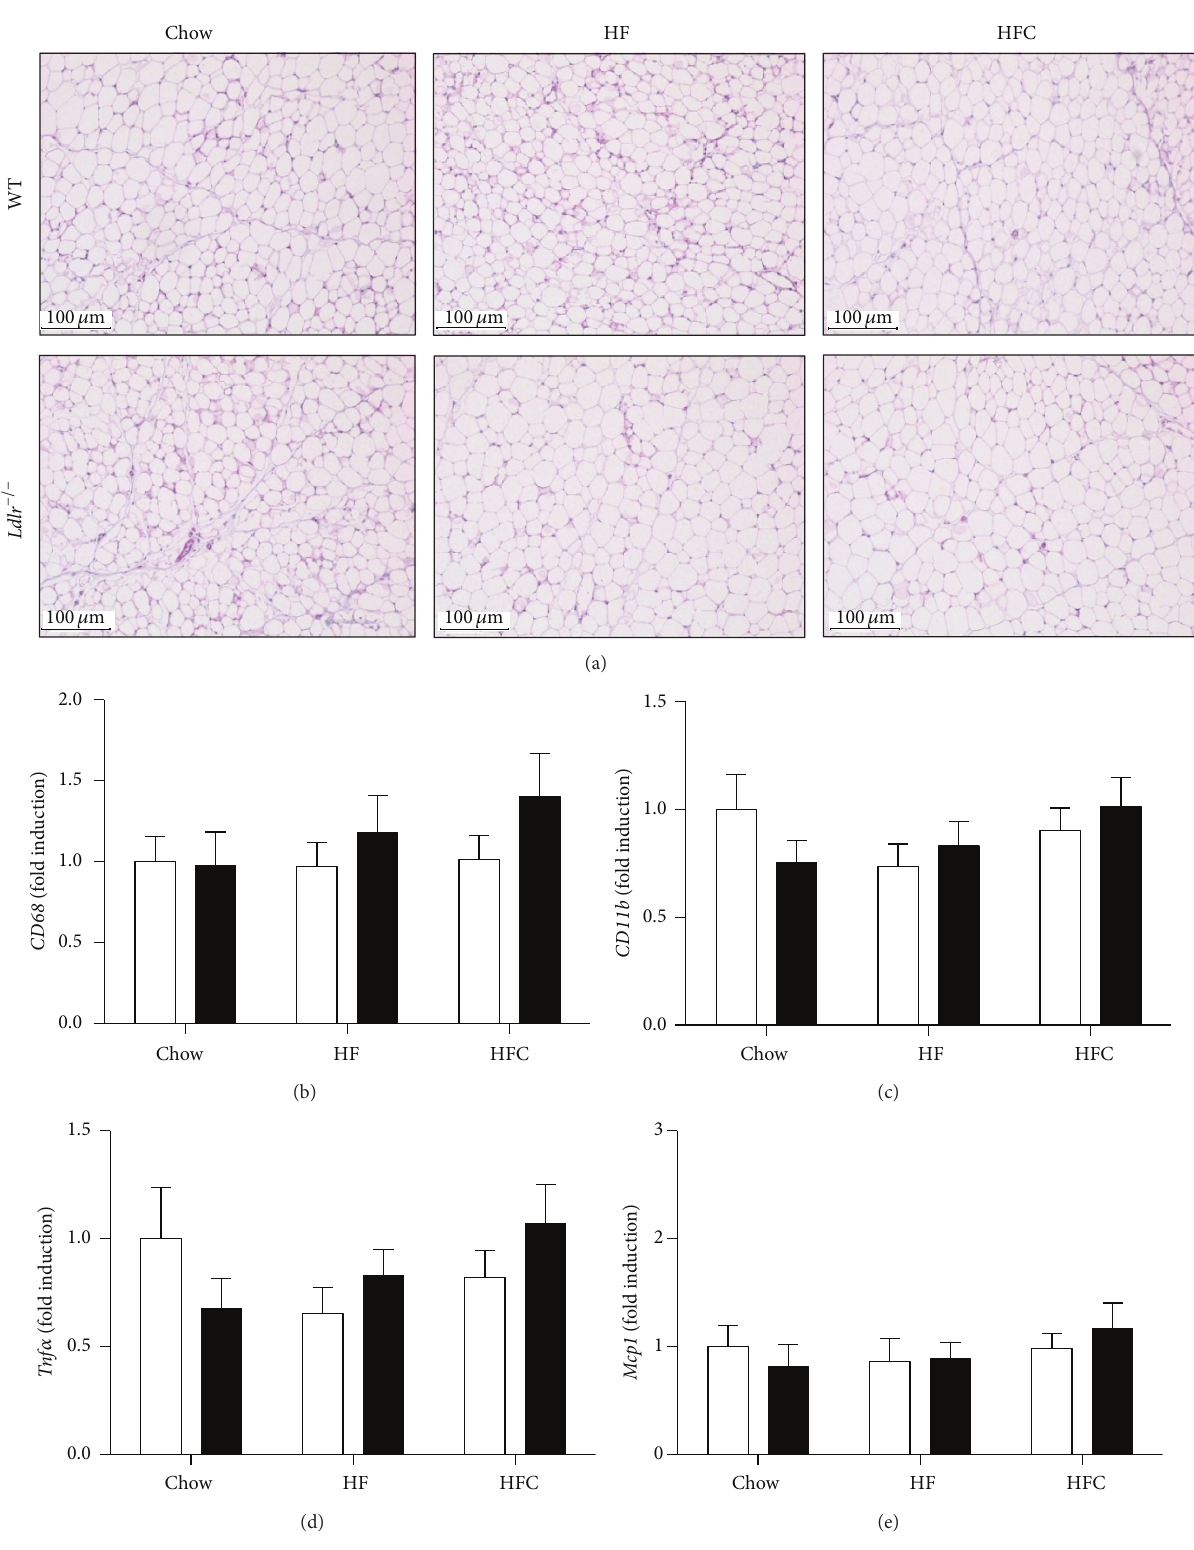
Figure 3: Absence of adipose tissue inflammation in Ldlr −/− mice fed a chow, HF, or HFC diet for 2 weeks. Representative pictures of paraffin- embedded white adipose tissue sections stained with hematoxylin-eosin (a) were taken from WT and Ldlr −/− mice fed a chow, HF, or HFC diet ( 𝑛 = 5-6). RNA was isolated from white adipose tissue and the expression of the proinflammatory genes Cd68 (b), Cd11b (c), Tnfa (d), and Mcp1 (e) was determined by real-time PCR and expressed as fold induction ( 𝑛 = 11 -12). Data are expressed as means ± SEM for WT mice (white bars) and Ldlr −/− mice (black